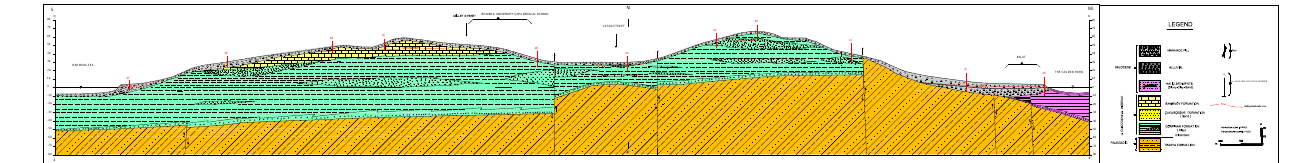
Figure 6. The location of the points on the 4-4 0 cross section where the 1-D and 2-D analyses were performed (Ince et al., 2008).